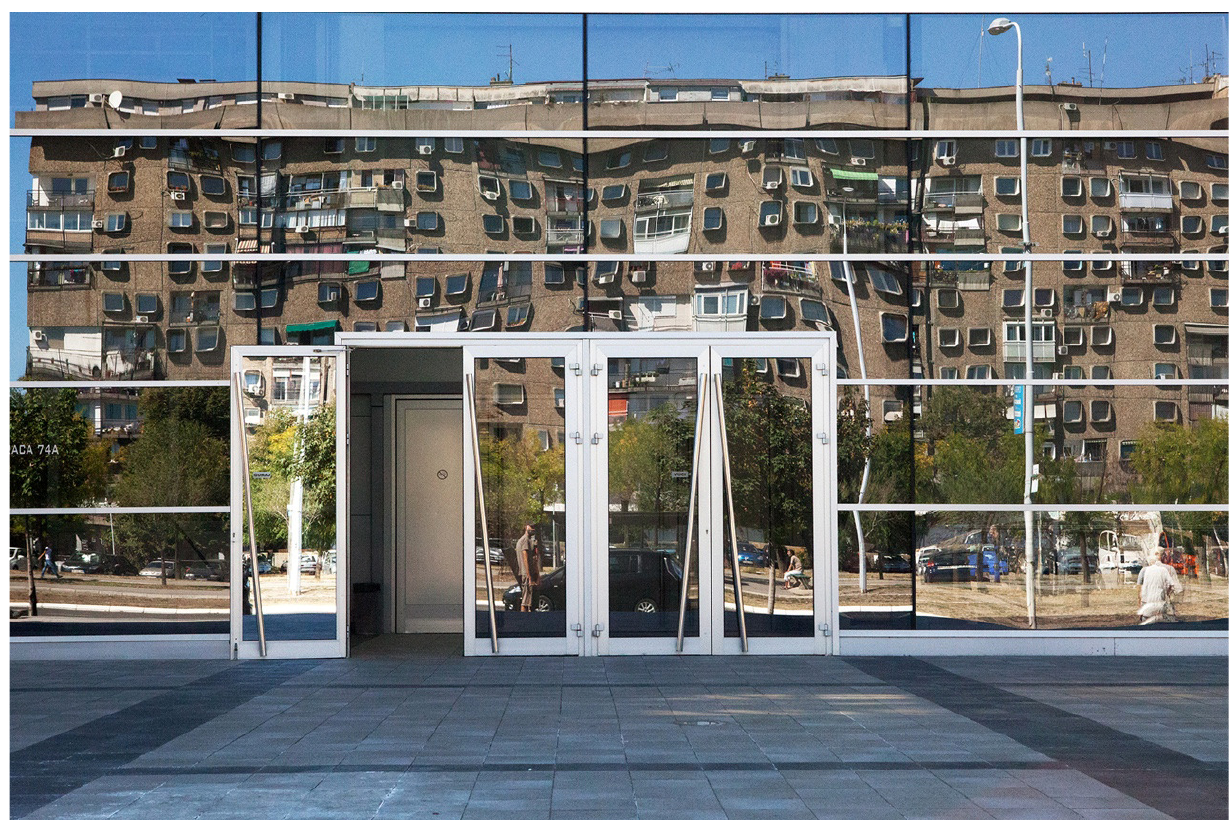
Figure 7. Block 28, New Belgrade: “Old and new spaces.” Source: OginoKnauss